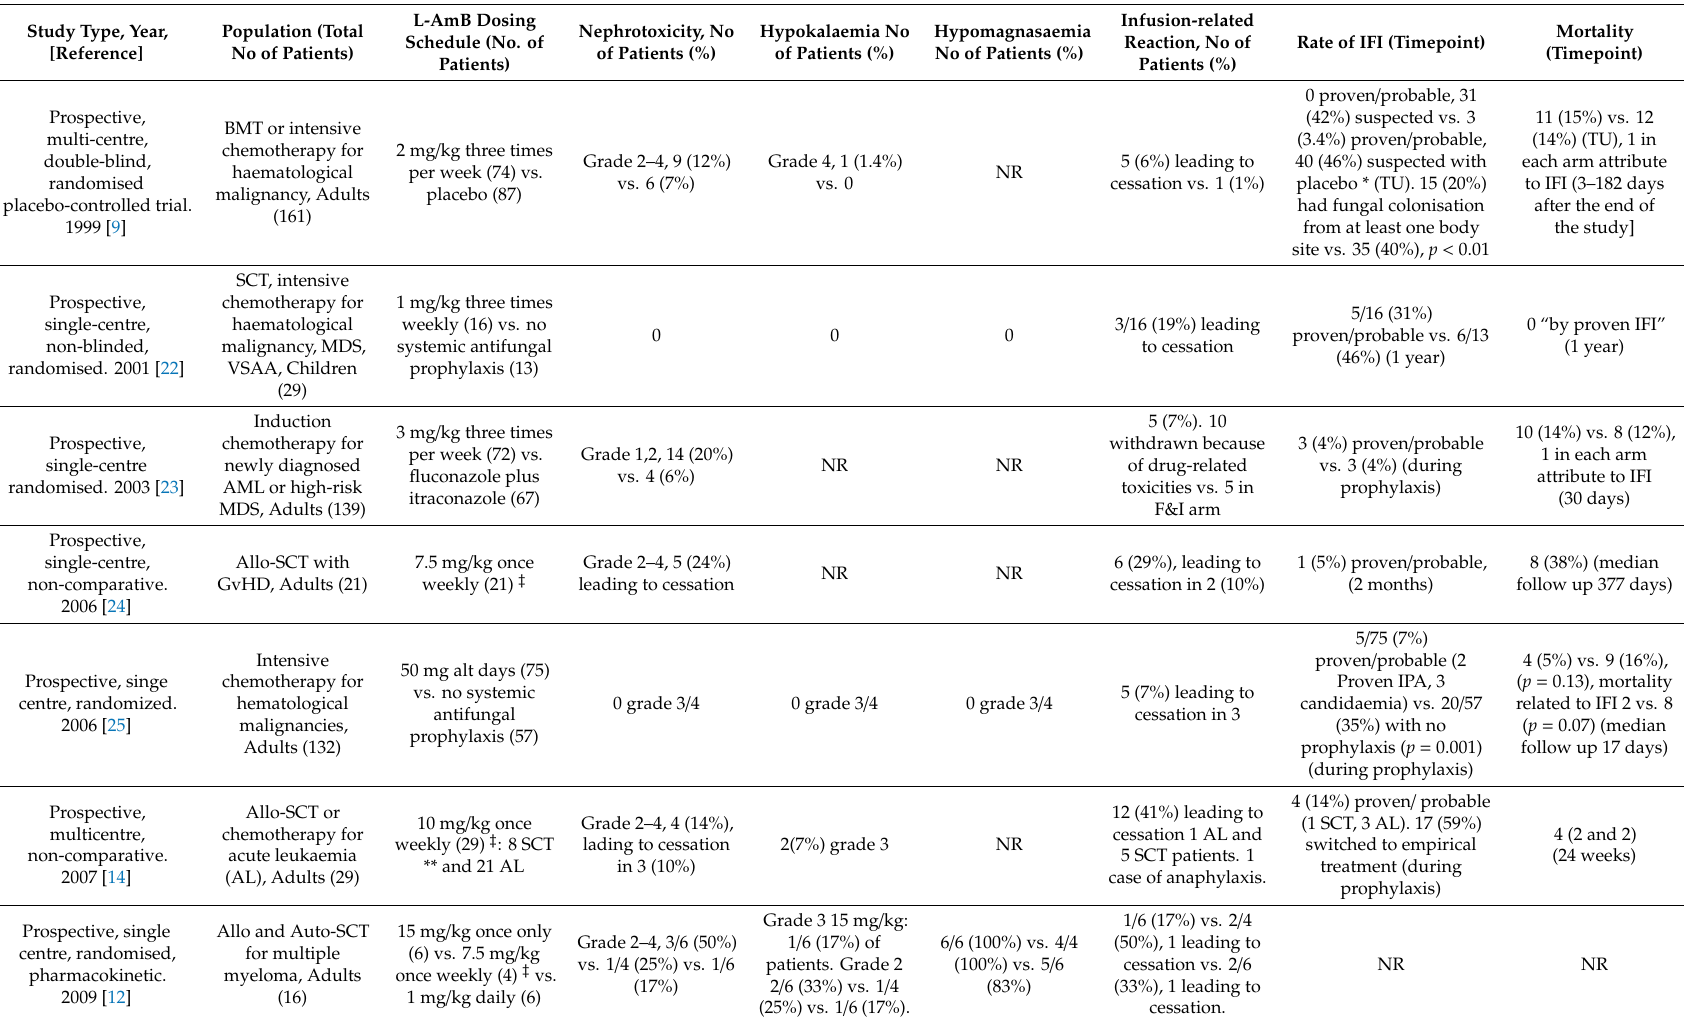
Table 1. Summary of studies on the use of L-AmB